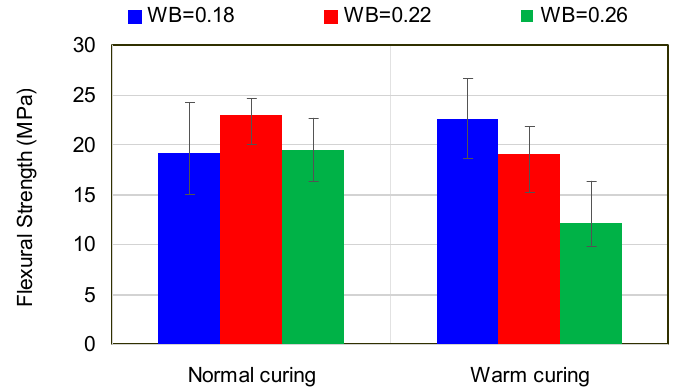
Figure 8. Effect of WB and curing temperature on flexural strength.